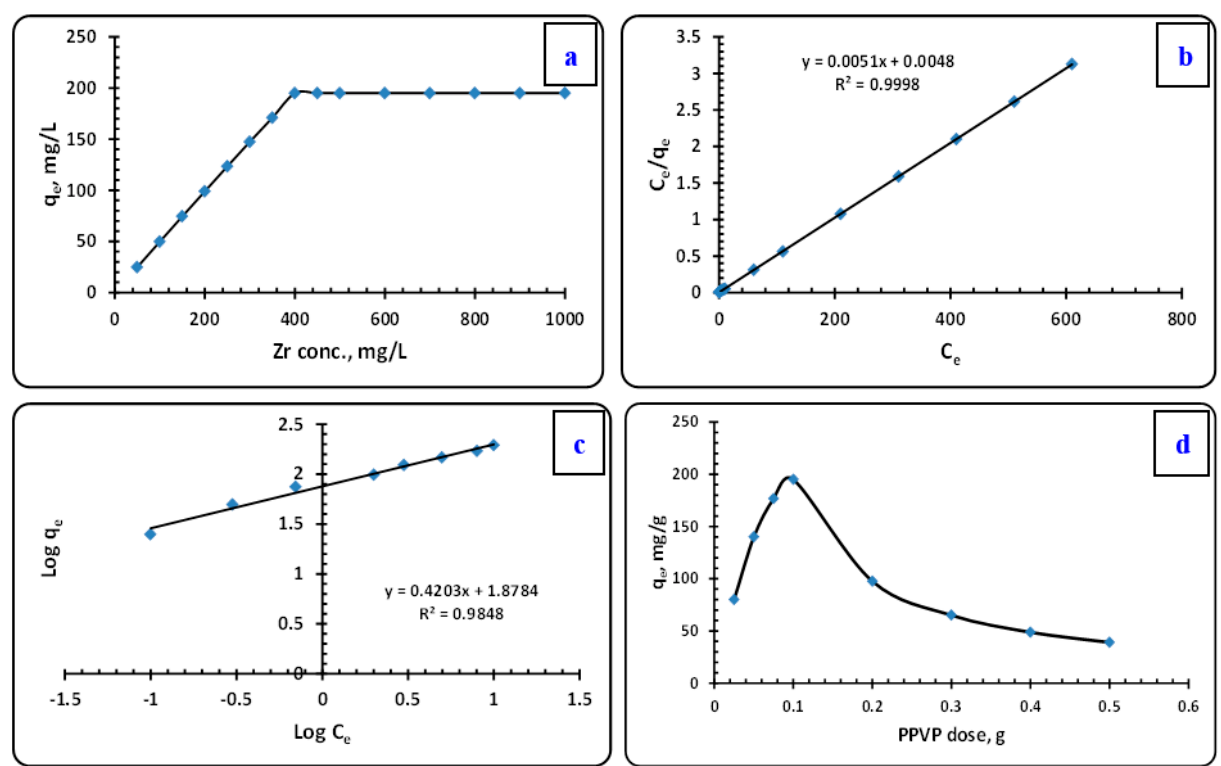
Figure 9. ( a ) Influence of initial zirconium ions concentration upon zirconium uptake by PPVP. ( b ) Langmuir isotherm modeling. ( c ) Freundlich isotherm modeling. ( d ) Effect of PPVP dose on Zr uptake. (Conditions: V: 50 mL, shaking time: 20 min, m: 0.1 g, T: 25 º C, pH: 0.)